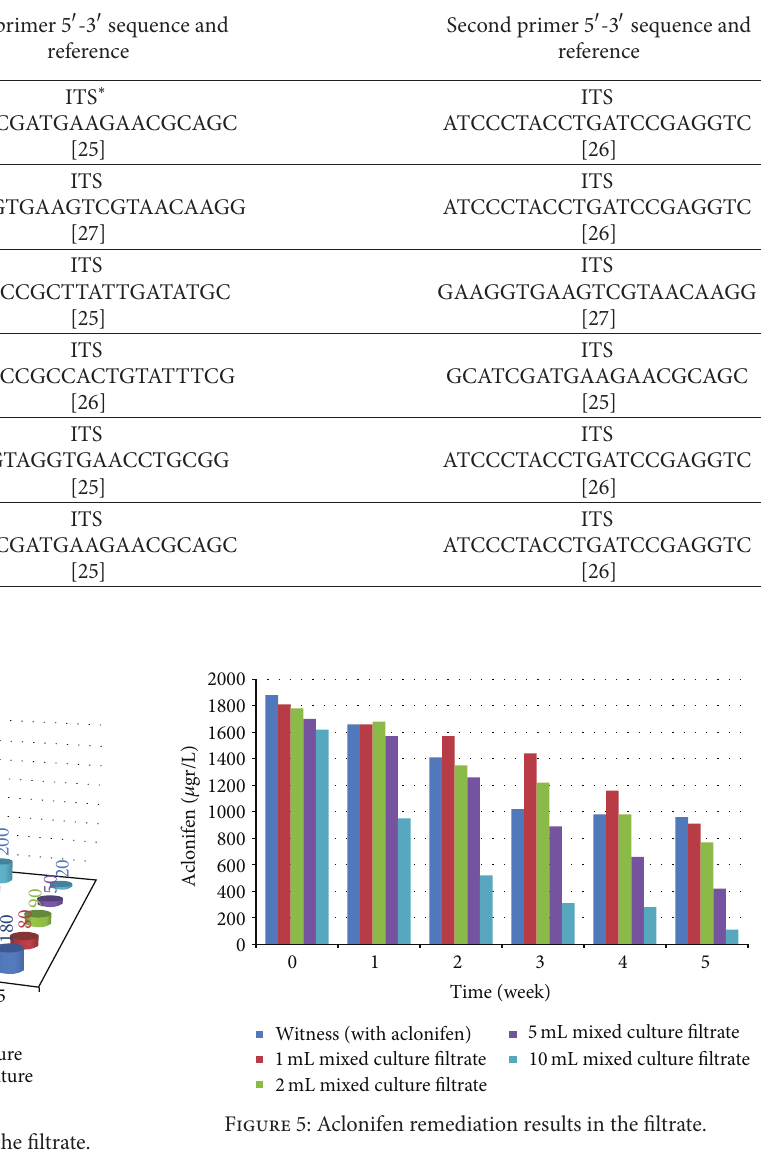
(without culture) and the 1 mL, 2 mL, 5 mL, and 10 mL mixed cultures increased proportionally, the TOC, COD, and BOD values also